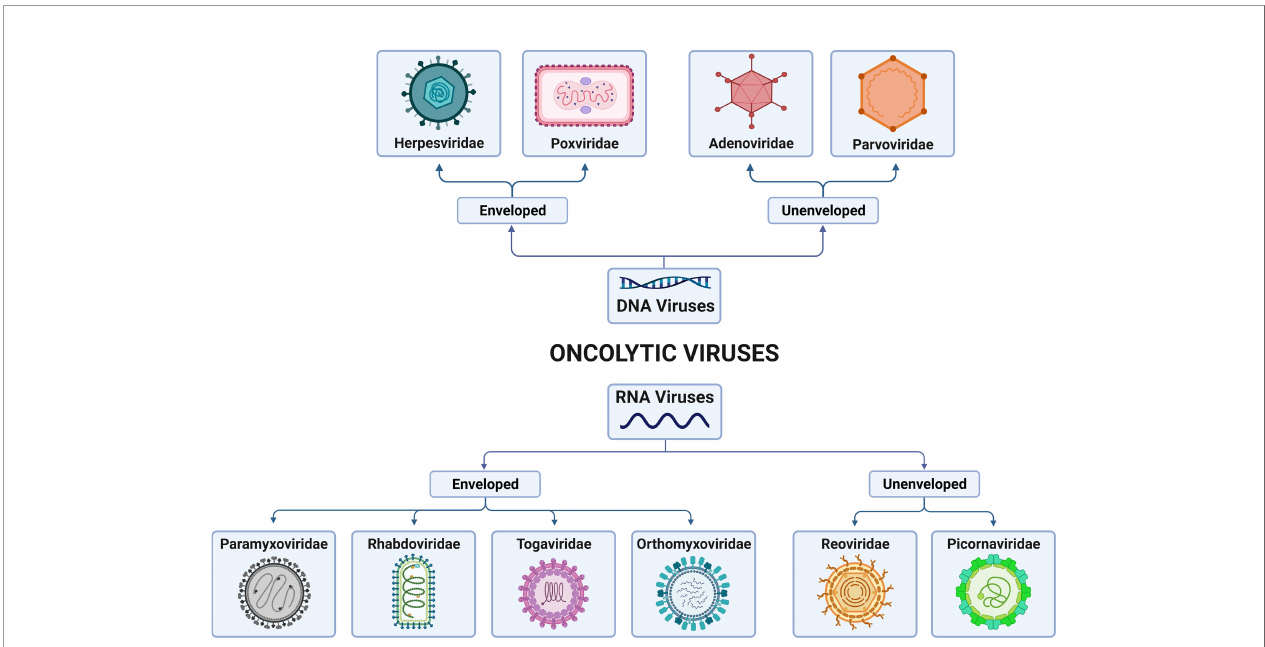
FIGURE 1 | Classi fi cation of families of oncolytic viruses (OVs) according to the genome and presence/absence of the viral envelope. OVs can be differentiated into DNA viruses and RNA viruses, depending on their genomic nature. In addition, both types can present, or not present, virus envelopes. Thus, DNA-enveloped viruses include those of the Herpesviridae and Poxviridae families; non-DNA-enveloped viruses include those of the Adenoviridae and Paroviridae families; RNA- enveloped viruses include those of the Paramyxoviridae, Rhabdoviridae, Togaviridae and Orthoyxoviridae families; and non-RNA-enveloped viruses include those of the Reoviridae and Picornaviridae families. Created with